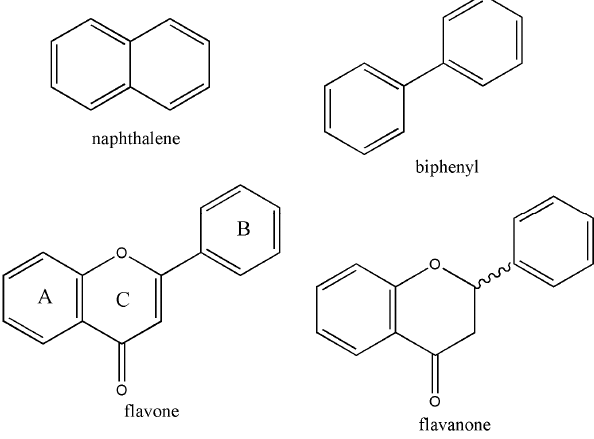
Figure 1. Molecular structures of flavone and the related compounds.